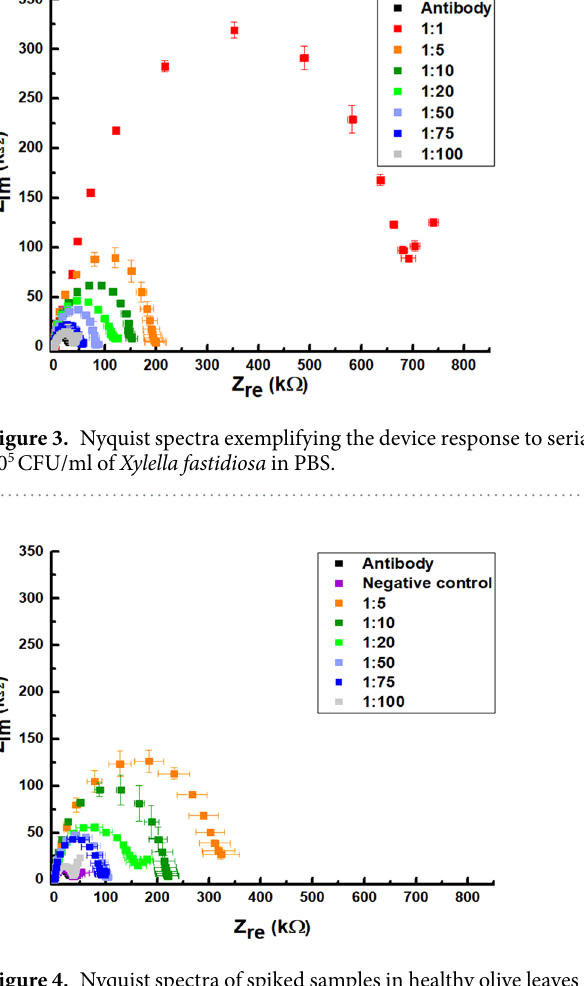
Figure 4. Nyquist spectra of spiked samples in healthy olive leaves homogenate. Serial dilutions of samples have been obtained from stock solution containing 10 5